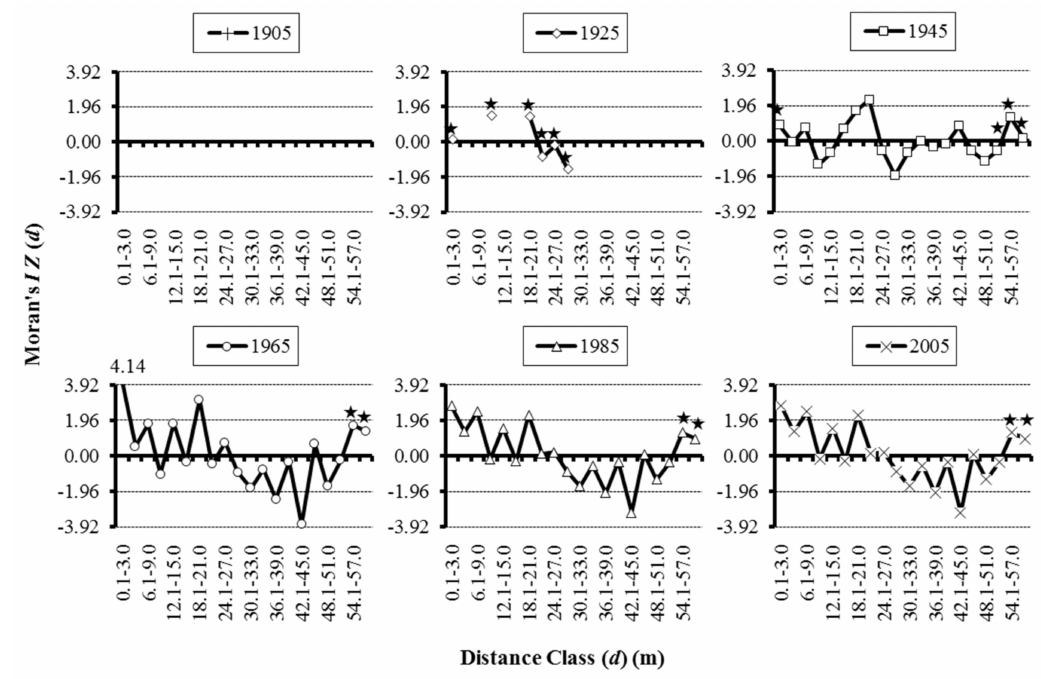
Figure 4. Contemporary and historical spatial autocorrelation correlograms for Mexican piñon ( Pinus cembroides var. cembroides Zucc.) of study site 1. Dotted lines in the middle of each graph indicate the 0.05 significance level, and stars ( (cid:70) ) indicate fewer than 20 neighbors for the specified distance class. The 1905 correlogram is left intentionally empty to emphasize that sampling depth did not extend into 1905.